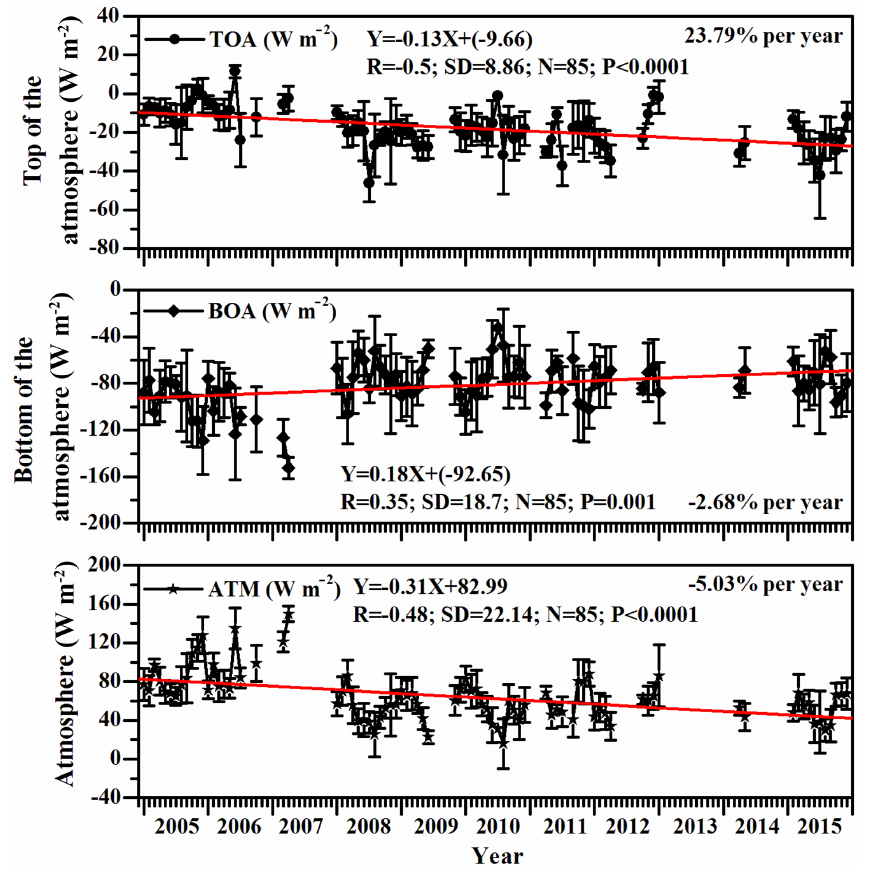
Figure 14. Long-term monthly mean variation in radiative forcing at the TOA (Wm − 2 ), BOA (Wm − 2 ) and in the ATM (Wm − 2 ). The vertical bar at each data point represents the standard deviation from the